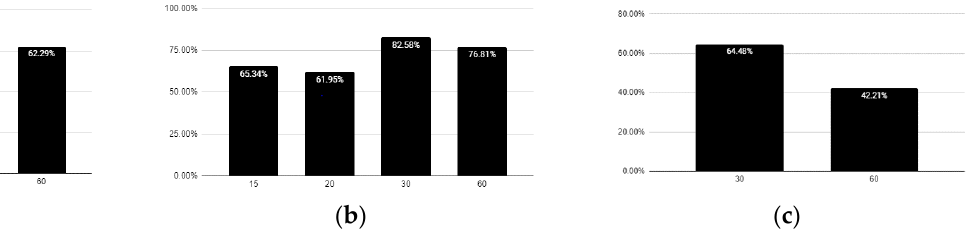
Next, we explore the image ’ s frame rate difference in the recognition rate. Since the